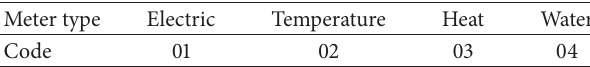
Table 1: Coding of